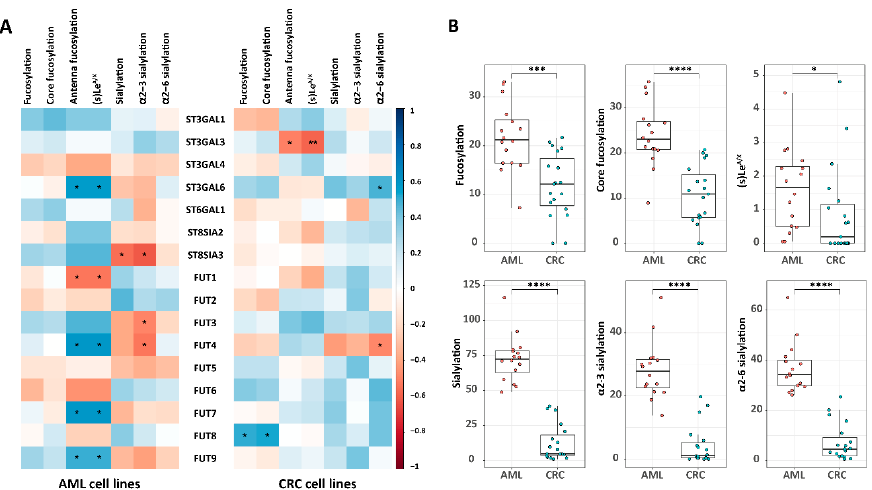
Figure 4. Correlations of glycosylation with relevant glycosyltransferases (GTs) and differences of glycosylation features in CRC and acute myeloid leukemia (AML) cell lines. ( A ) Correlation analysis was conducted between glycosylation features (relative quantification %) and corresponding GTs in CRC cell lines with the Spearman method. ( B ) The differences between groups (AML vs. CRC cell lines) were tested with Wilcoxon–Mann–Whitney nonparametric statistical test. The glycosyla- tion features with significant differences between AML and CRC cell lines were displayed in ( B ). p - values were corrected by the Benjamini–Hochberg method. Significant values are marked with * ( p ≤ 0.05), ** ( p ≤ 0.01), *** ( p ≤ 0.001), and **** ( p ≤ 0.0001). The R2 scale is indicated in the right key bar of subfigure ( A ) (blue: positive correlation; red: negative correlation).